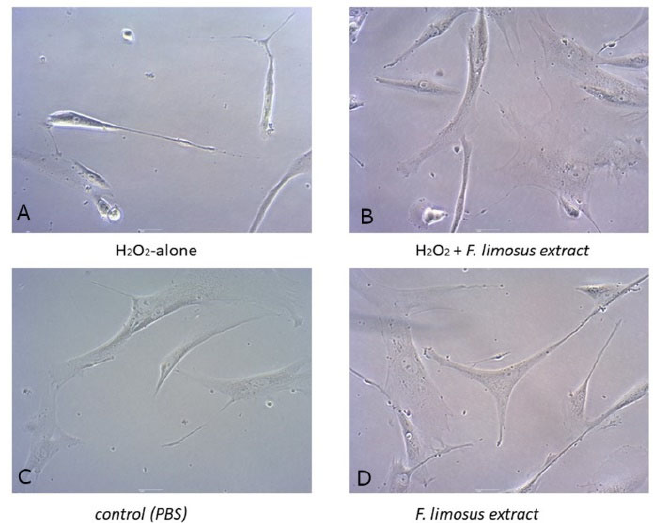
Figure 2. Morphology of cells treated with F. limosus extract or PBS and/or H 2 O 2 . ( A ) Cells treated only with 100 uM/mL hydrogen peroxide. ( B ) Cells treated with 100 ug/mL crayfish extract and 100 uM/mL hydrogen peroxide. ( C ) Control cells treated only with PBS. ( D ) Cells treated only with 100 ug/mL crayfish extract. Scale bar: 1 μ m.